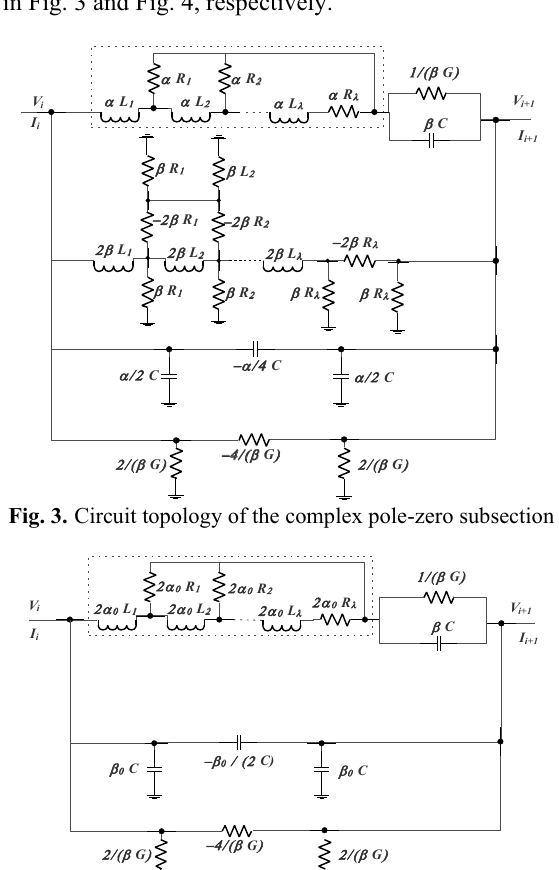
Fig. 7. Transient response of the circuit shown in Fig. 2